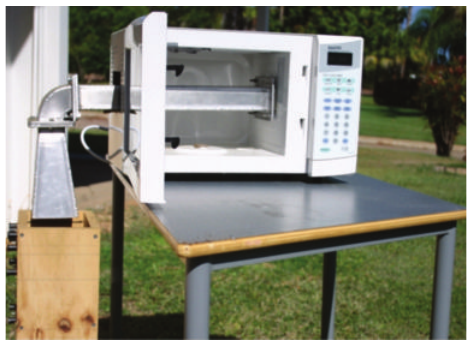
Figure 5: A laboratory prototype system based on a modified mi- crowave oven.